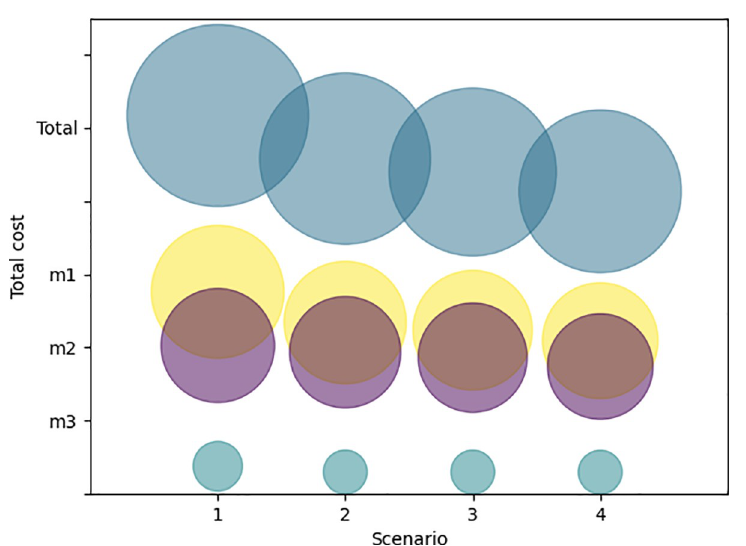
Fig 14. Cost comparison of the four